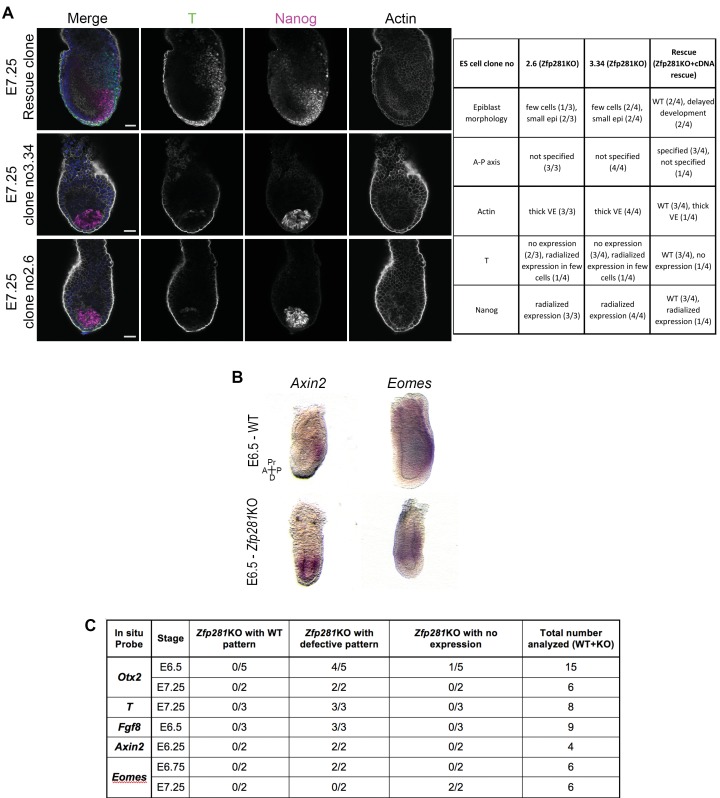
WISH analysis of Otx2, Axin2, and Eomes in WT and Zfp281KO embryos.(A) Immunohistochemistry of pluripotency factor Nanog, the primitive streak marker T and Actin. Nanog and T exhibit radialized expression in tetraploid chimera containing Zfp281KO epiblast cells (similar to Zfp281KO embryos), whereas rescued chimera show a pattern similar to WT. (B) Wholemount in situ hybridization (WISH) analysis of Otx2 reveals expression at the anterior of a WT embryo. In Zfp281KO embryos, Otx2 is expressed at the distal tip. (C) Table recapitulating the markers and number of embryos analyzed by WISH. A = Anterior, p=Posterior, Pr = Proximal, D = Distal. Scale bars represent 50 µm.